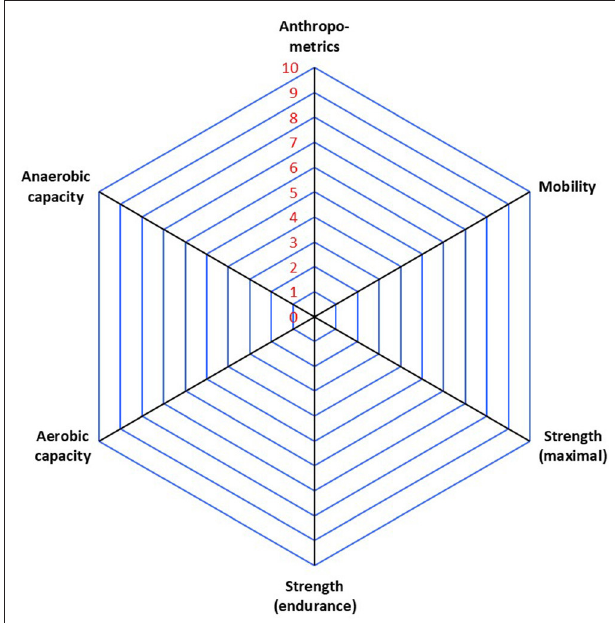
FIGURE 3 | Overview of the SF operators’ physical performance key determinants, as identified based on in-the-field observations, international benchmarking, and the available